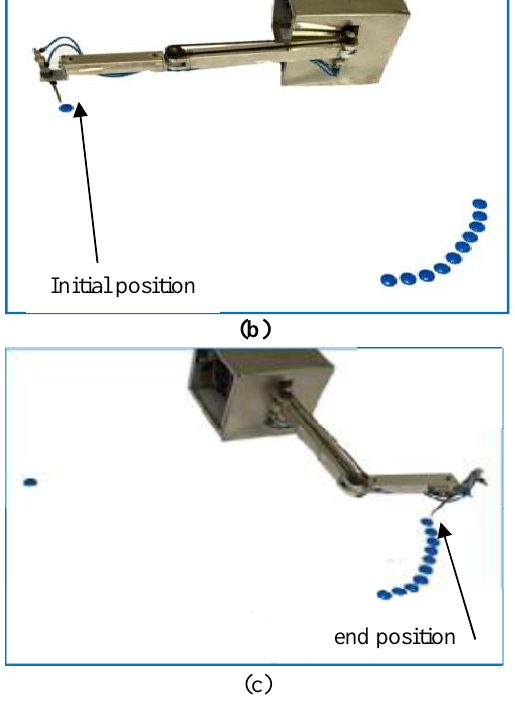
Fig. 16. ( a) the desired second path.(b&c) The Second Practical Motion